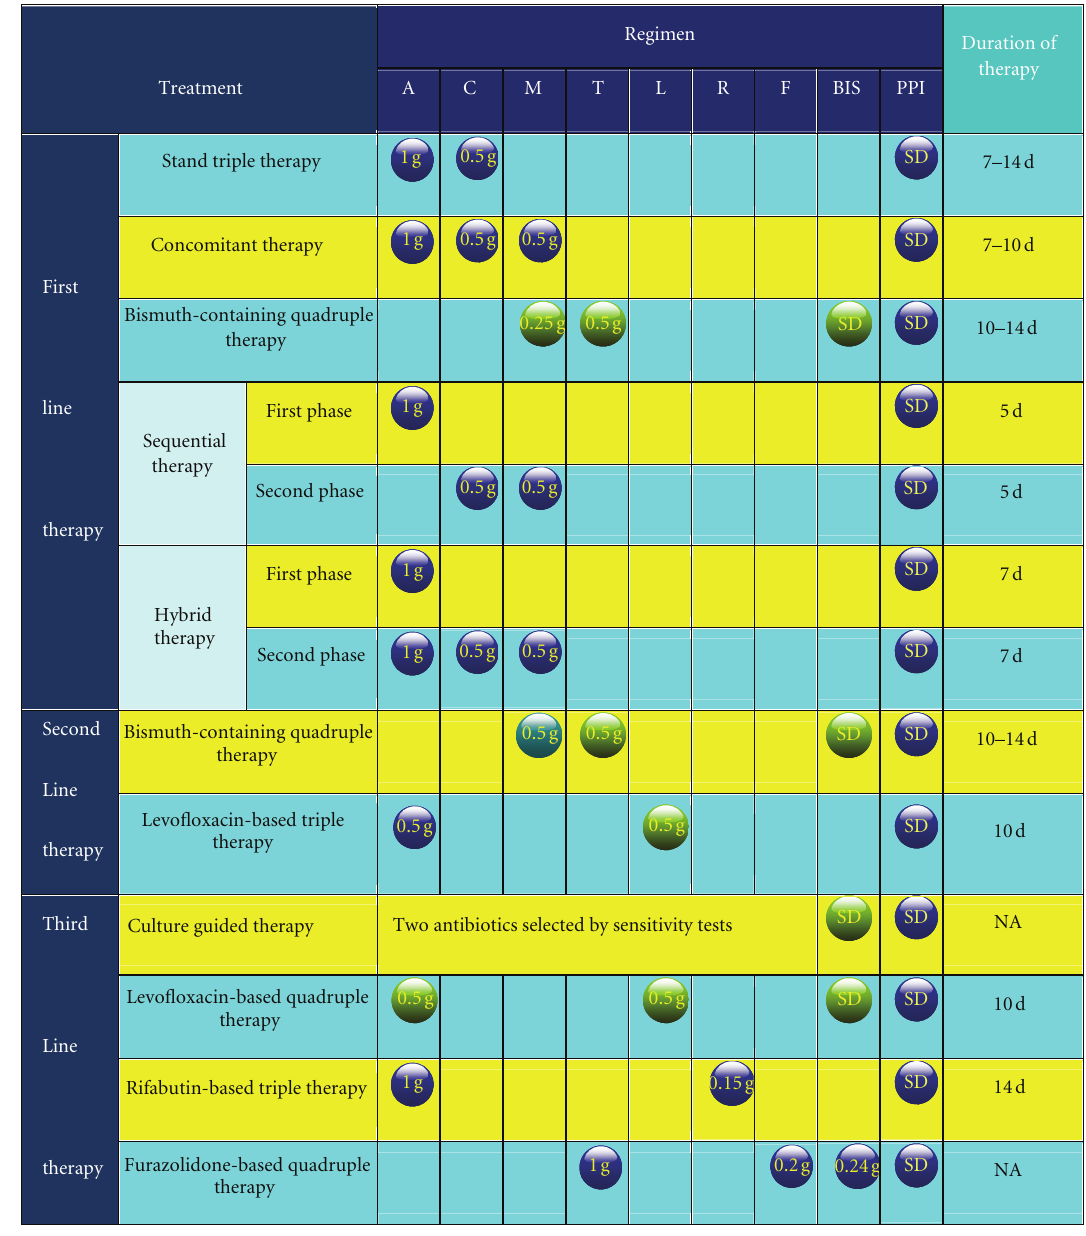
Figure 3: Current recommended regimens for H . pylori eradication. The figure in the ball stands for dose. Blue ball: b.i.d, purple ball: t.i.d, green ball: q.i.d. A: amoxicillin, C: clarithromycin, M: metronidazole, T: tetracycline, L: levofloxacin, R: rifabutin, F: furazolidone, SD: standard dose, BIS: bismuth, PPI: proton pump inhibitor, modified from